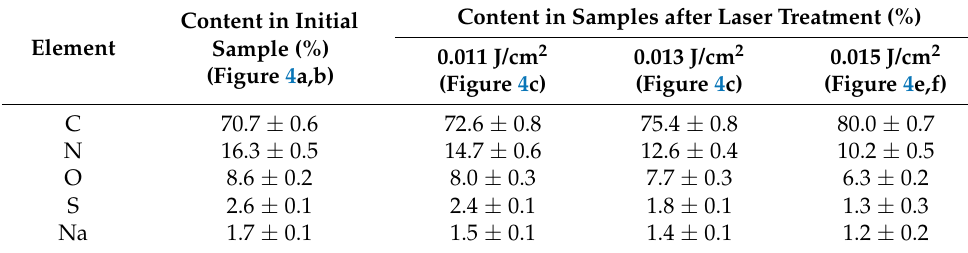
Table 2. Results of EDX